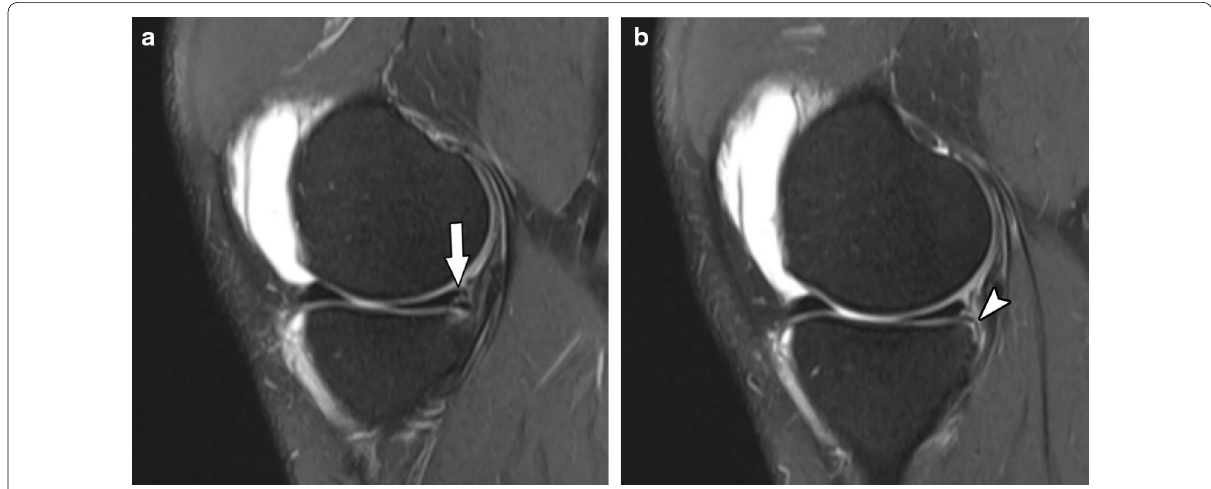
Fig. 7 Type 3A meniscal ramp lesion MRI Case. Sagittal T2‑weighted fat‑suppressed images show peripheral vertical partial tear (arrow in a ) extending to the tibial surface of the posterior horn of medial meniscus, with intact meniscotibial ligament (arrowhead in b